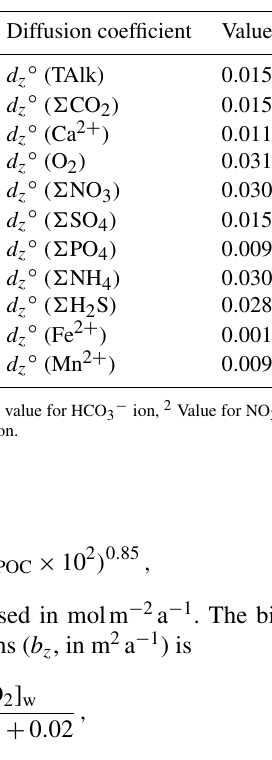
Table 5. Temperature-dependent molecular diffusion coefficients (m 2 a − 1